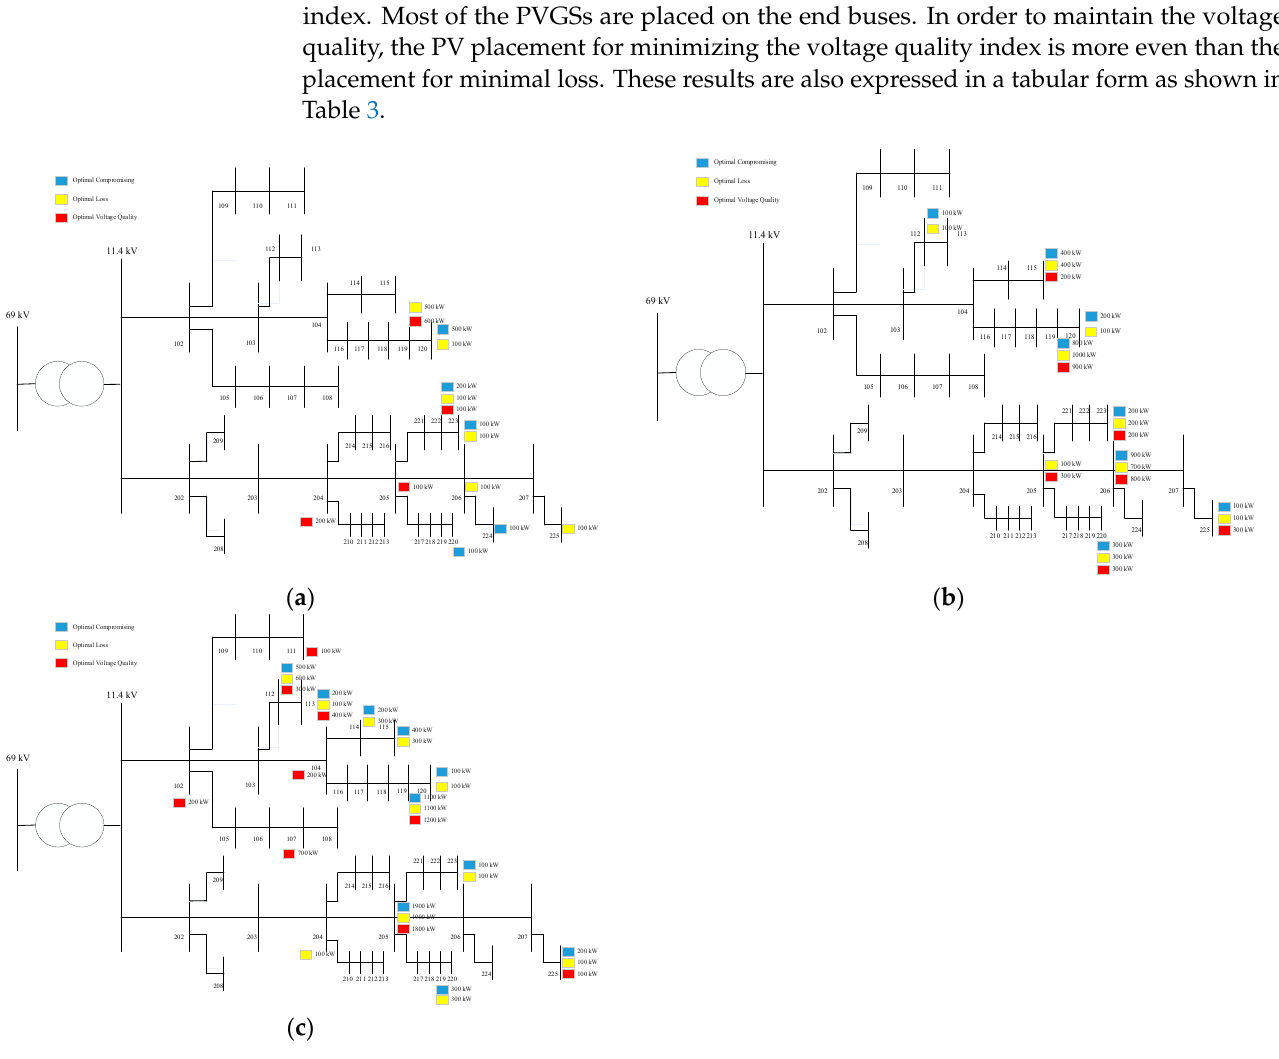
Figure 8. Optimal PV placements for different objectives. ( a ) PV installed capacity 1000 kW; ( b ) PV installed capacity 3000 kW; ( c ) PV installed capacity 5000 kW.